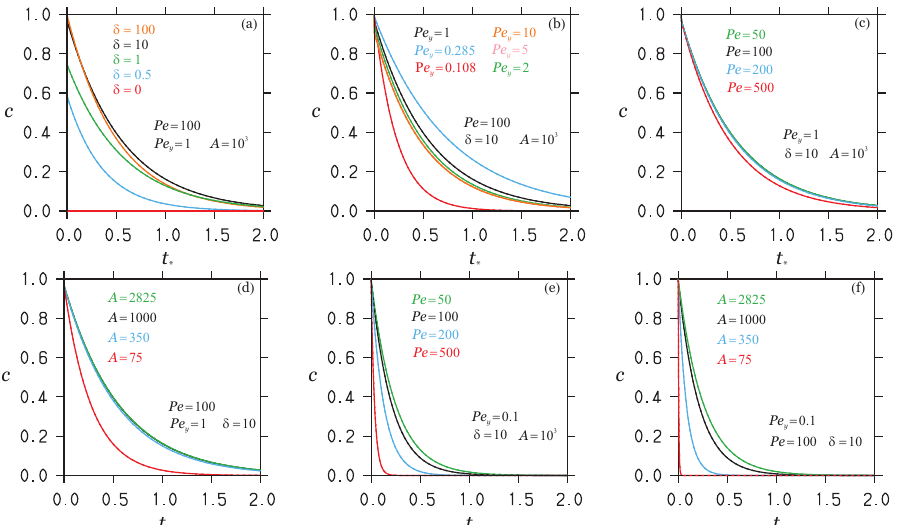
Figure 9. The concentration distribution ( a – f ) as function of time t ∗ at x ∗ = x 2 ∗ , y ∗ = y 2 ∗ (solid lines) by considering the same cases as in Figure 7 (solid lines). The dashed lines show the results of using only the lowest eigenvalue contributions in Equations (A17)–(A19): there is no visible difference to solid